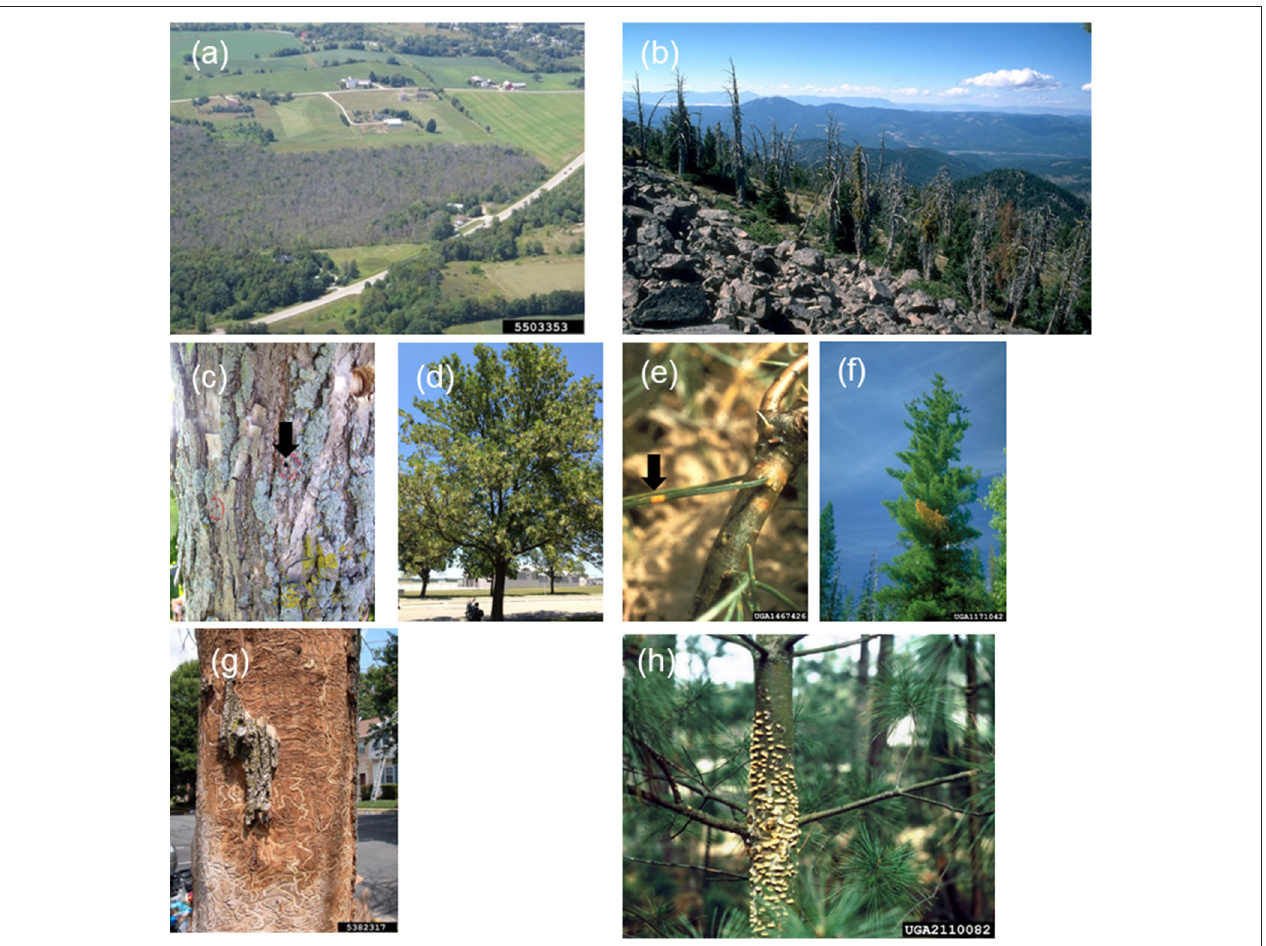
FIGURE 1 | Examples of landscape-, tree-, and tissue-scale presentations of tree-killing non-native phytophagous insects and phytopathogens. Landscape-scale tree mortality resulting from (a) emerald ash borer and (b) white pine blister rust. Problematic hidden nature of infestations, such as (c) small adult beetle emergence holes and (d) non-descript canopy thinning seen in early emerald ash borer infestation, or (e) small lesions and (f) branch flagging seen in early white pine blister rust disease development. (g,h) Damage to critical vascular tissues or meristems leads to rapid decline and death of trees without adequate defenses. Image credits: (a) Bill McNee, Wisconsin Dept of Natural Resources, Bugwood.org. (b) Dave Powell, USDA Forest Service (retired), Bugwood.org. (e) USDA Forest Service – Ogden, Bugwood.org. (f) Chris Schnepf, University of Idaho, Bugwood.org. (g) Eric R. Day, Virginia Polytechnic Institute and State University, Bugwood.org. (h) Frantisek Soukup,